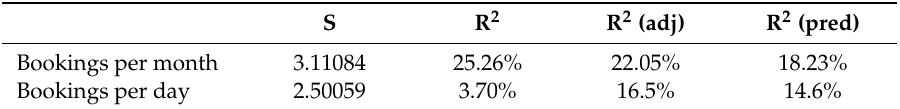
Table 3. One-way ANOVA model